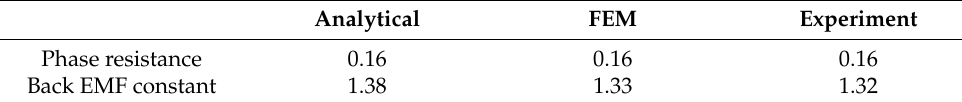
Figure 13. Comparison of back EMF analysis. Table 5. Comparison of phase resistance and back EMF constant.